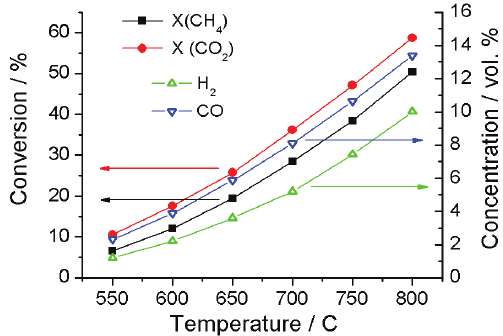
Figure 18b: Temperature dependence of reagents conversions and products concentrations for 5Ni/Ce + 15% CO in N . Contact time 8 ms, pretreatment 1 h at 400 o C in O 2 2 activation in reaction feed at 400 o